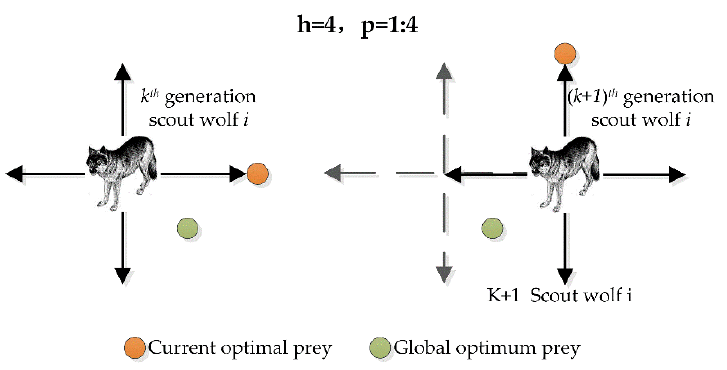
Figure 6. Schematic diagram of scout wolf.